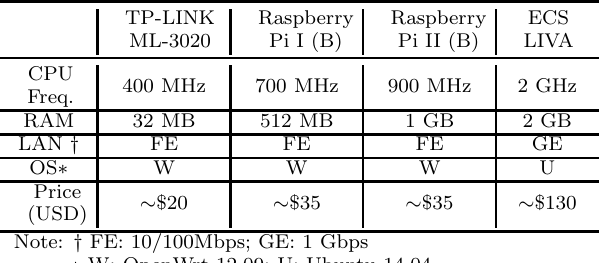
Table 2: The configurations of the four